Question: What visual encoding does this figure use to show its data?
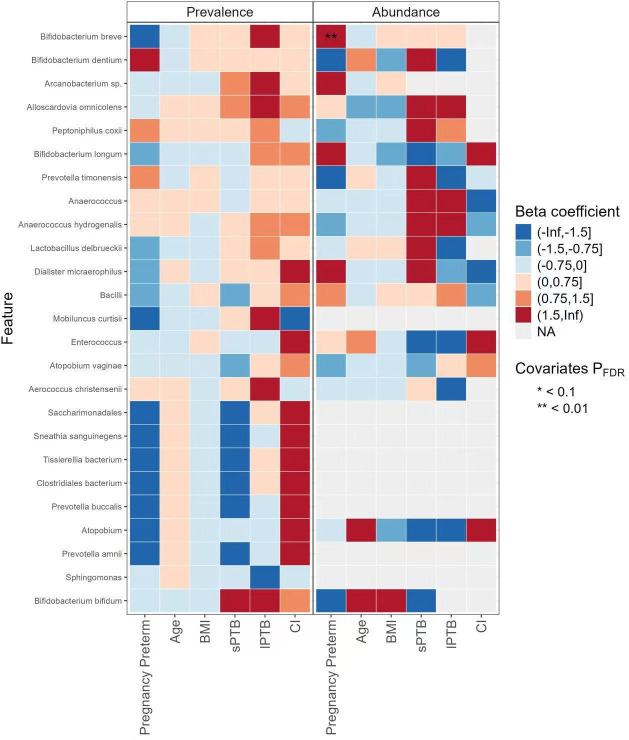
Answer: heatmap